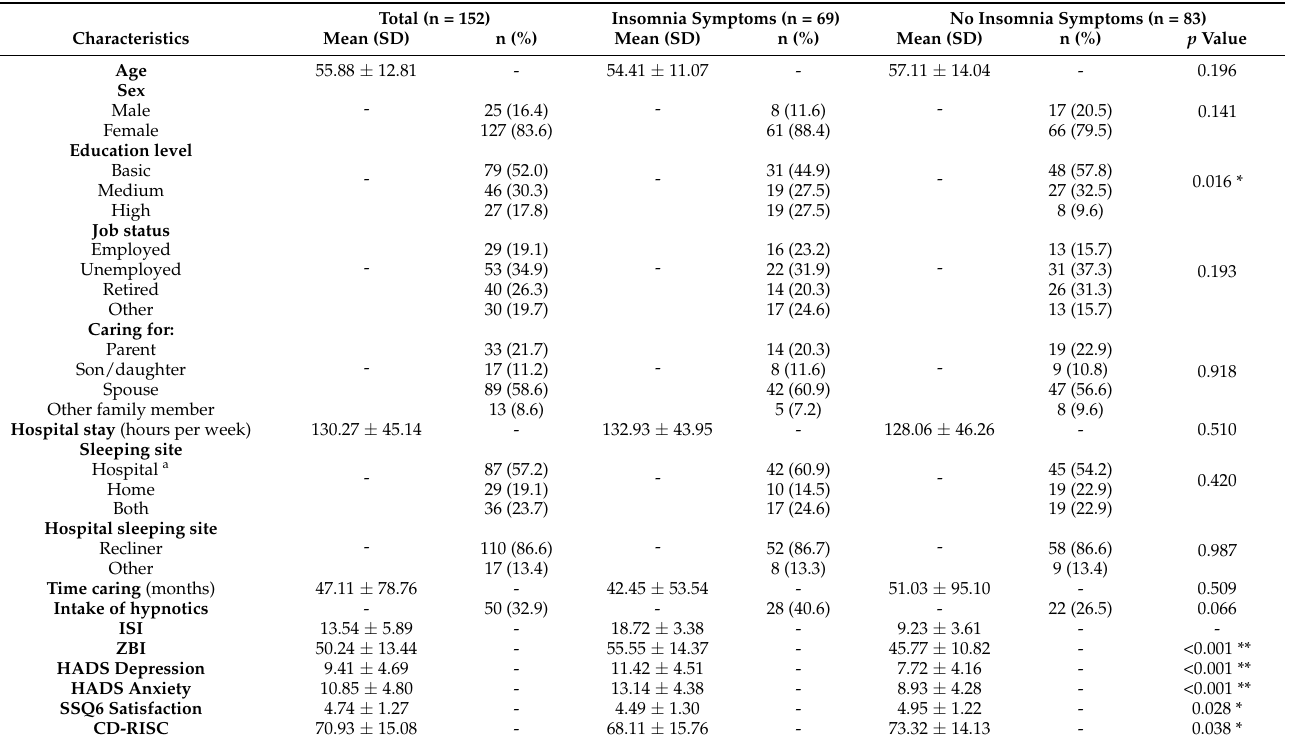
Table 1. Distribution of the baseline characteristics of the sample of informal caregivers according to the presence of insomnia symptoms.